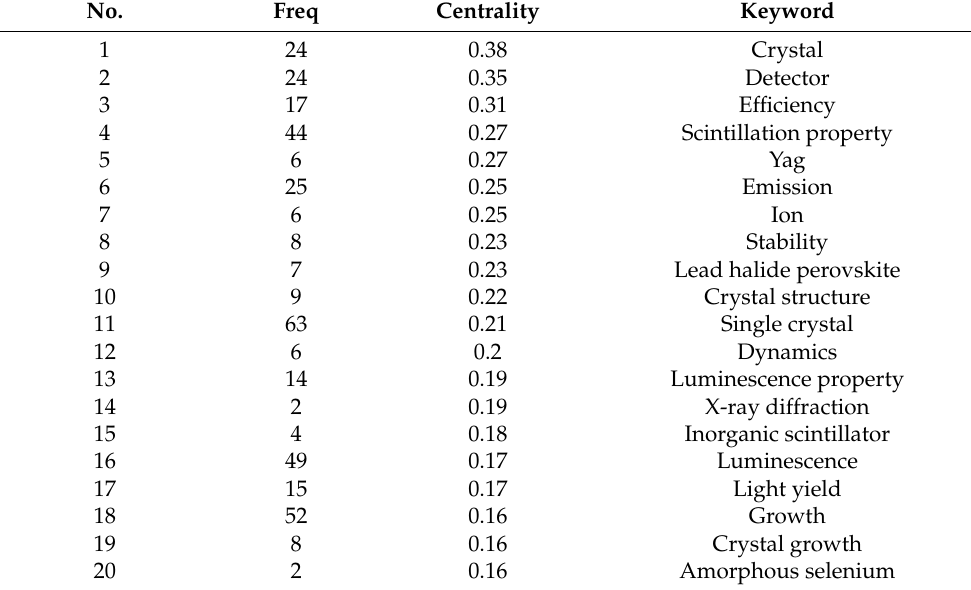
Table 4. Top 20 keywords according to